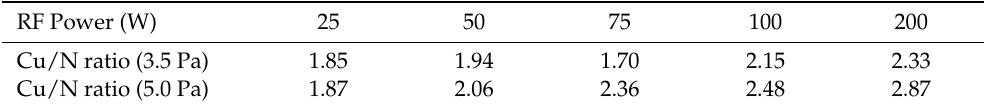
Table 4. Relative chemical composition of the Cu 3 N films in the study, derived from EDS analysis. RF Power